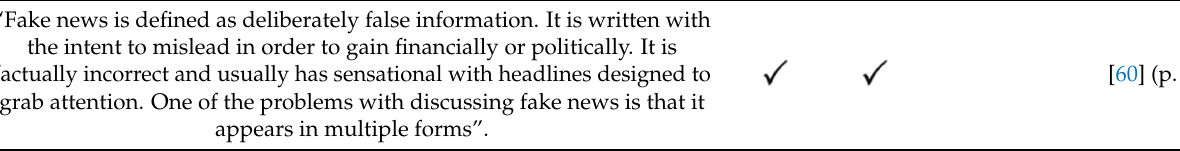
Table 1. Main proposals for the definition of fake news in the literature . Caption: (1) Completely or partially false statements; (2) there must be intent to mislead; (3) only in news format.